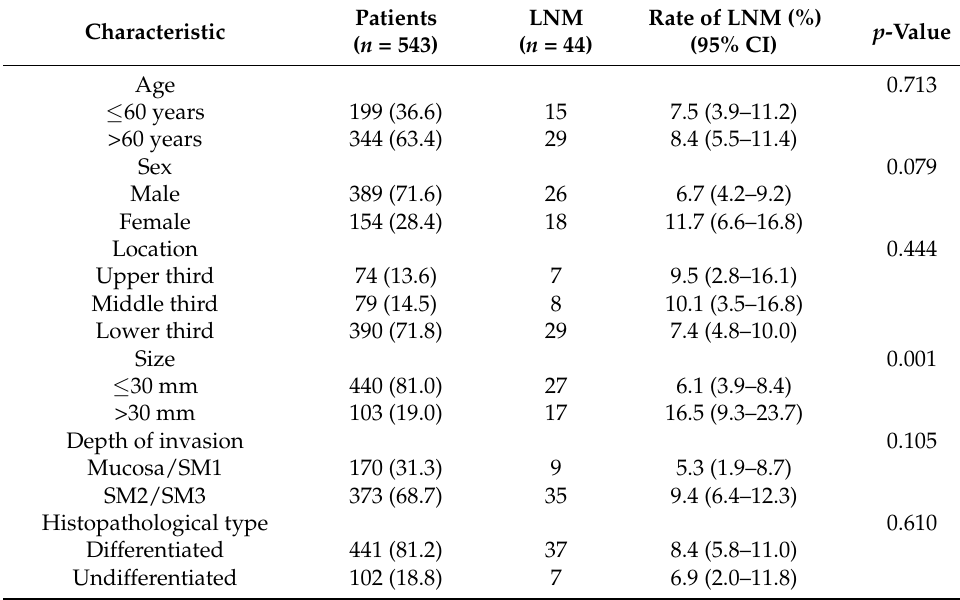
Table 2. Baseline characteristics and clinicopathological